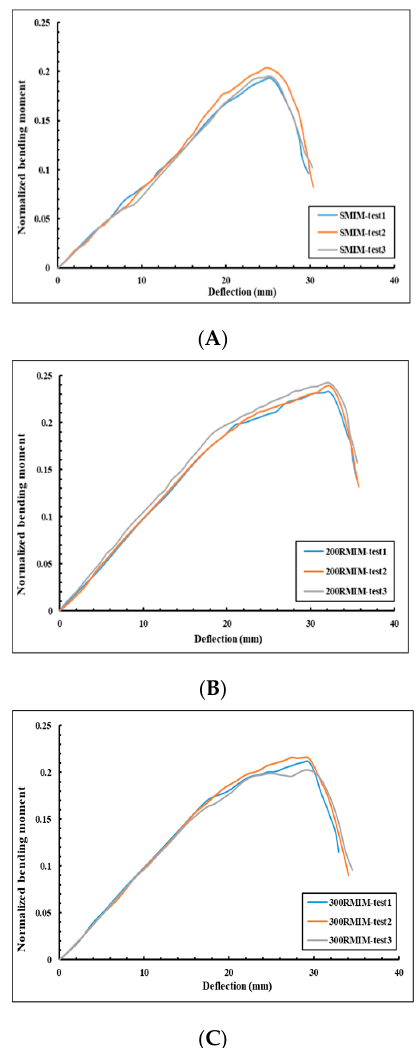
Figure 16. Normalized bending moment–deflection about minor axis test curves: ( A ) SMIM; ( B ) 200RMIM; ( C ) 300RMIM. Table 4. The ultimate normalized bending capacity of specimens in the minor axis